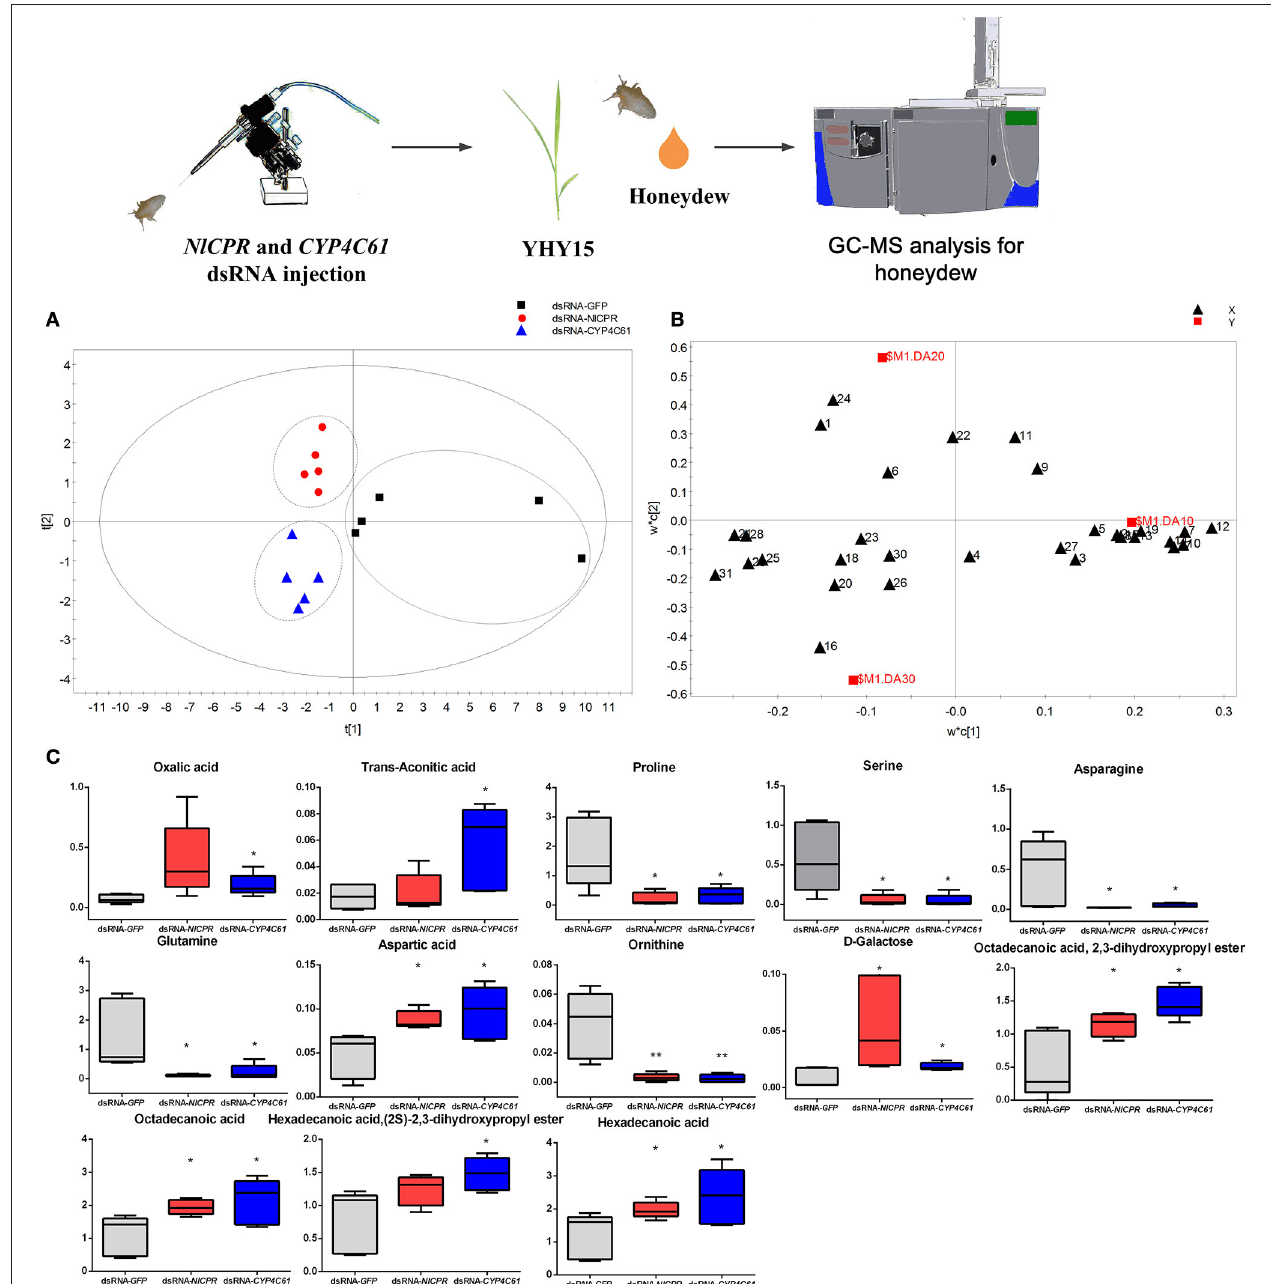
FIGURE 8 | Metabolomics analysis of NlCPR and CYP4C61 dsRNA-treated BPH honeydew on YHY15 plants. (A) PLS-DA score plots of dsRNA-treated BPH honeydew metabolites. (B) Loading plot of dsRNA-treated BPH honeydew metabolites. 1, Oxalic acid; 2, Valine; 3, Glycerol; 4, Phosphate; 5, Glycine; 6, Succinic acid; 7, Serine; 8, Threonine; 9, Malic acid; 10, Proline; 11, α -Hydroxypyruvic acid; 12, Ornithine; 13, Phenylalanine; 14, Asparagine; 15, α -Aminoadipic acid; 16, Trans-aconitic acid; 17, Glutamine; 18, D-Ribofuranose; 19, Shikimic acid; 20, 1,2,3-Propanetricarboxylic acid; 21, Aspartic acid; 22, D-Fructose; 23, D-Glucose; 24, D-Galactose; 25, Hexadecanoic acid; 26, Myo-Inositol; 27, Tryptophan; 28, Octadecanoic acid; 29, Hexadecanoic acid,(2S)-2,3-dihydroxypropyl ester; 30, α -D-Glucopyranoside; 31, Octadecanoic acid, 2,3-dihydroxypropyl ester. (C) Box plot of relative peak area data for honeydew metabolites. Each box plot shows the data distribution for each compound for all treatment groups. *, ** on the bars indicate significance at P < 0.05 and P < 0.01 ( t -test), respectively, when compared with the